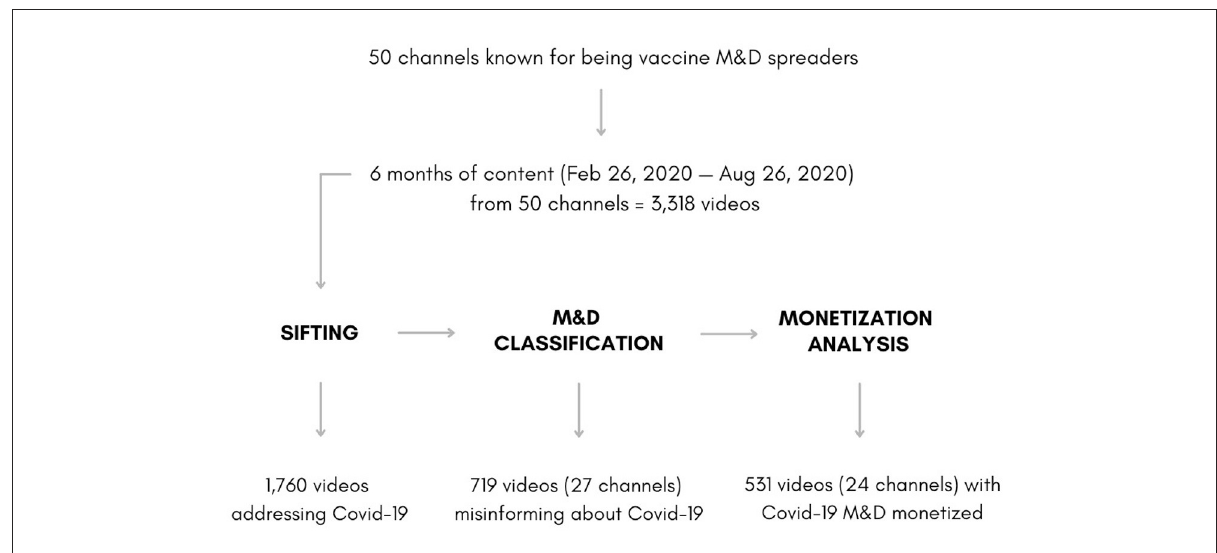
FIGURE1 Flowchart of the methodology steps performed by the